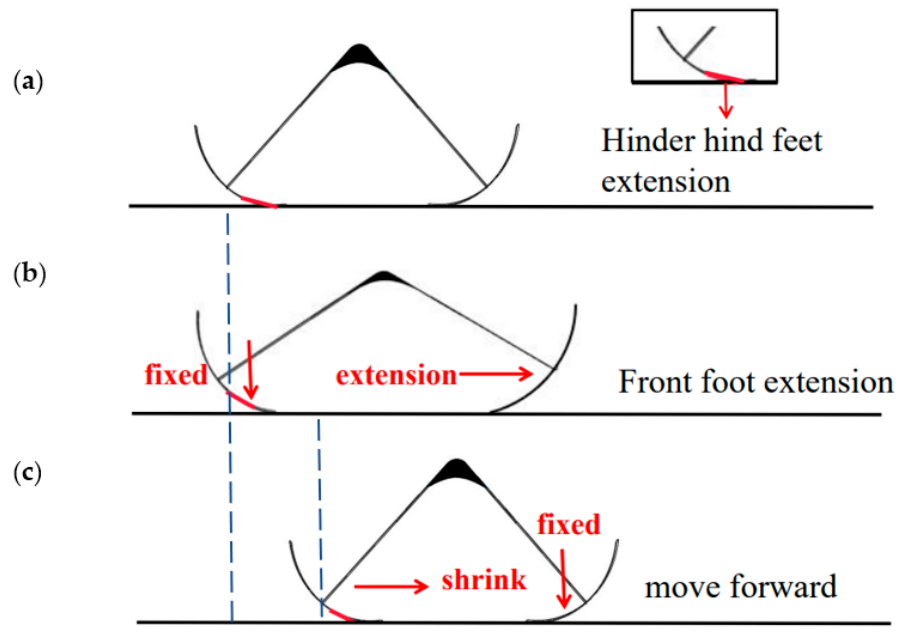
Figure 5. Forward running principle. Positioning the rear foot of the robot with a blue dotted line indicates that the robot is moving forward. ( a ) Power off state, hind foot fixed; ( b ) Power on situation, front foot extension; ( c ) Power off state, front foot fixed, hind foot shrink, robot moves forward.